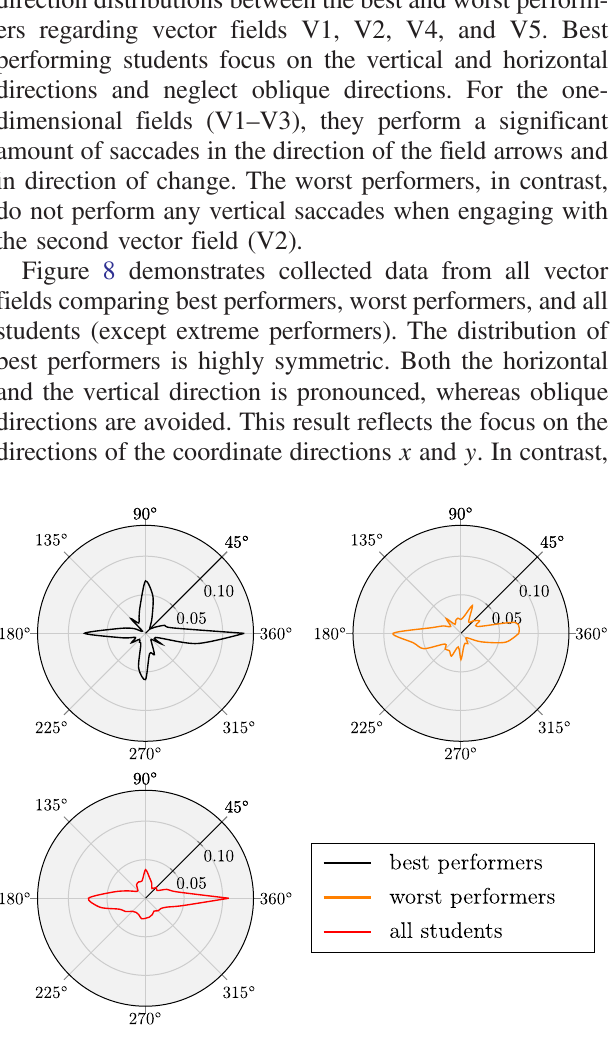
FIG. 8. Polar distribution of saccadic directions for the best performing students (upper left), worst performing students (upper right) and all students (extreme performers excluded; bottom) when they applied the differential strategy. Fixation data from all five vector fields were